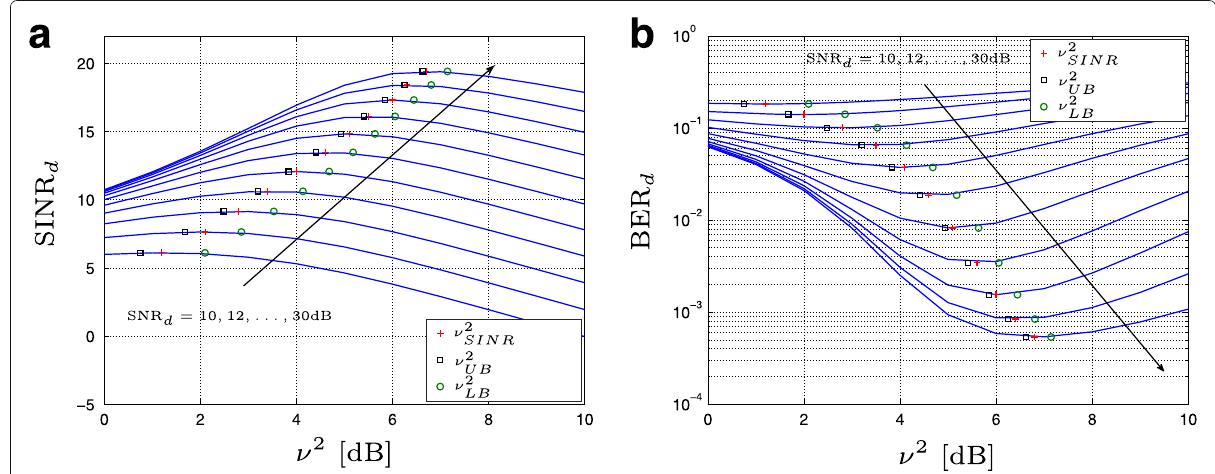
Fig. 4 Maximization of SINR a and minimization of BER b for the SL model and SNR d = 10,12, ... ,30 dB. Flat relay-destination channel